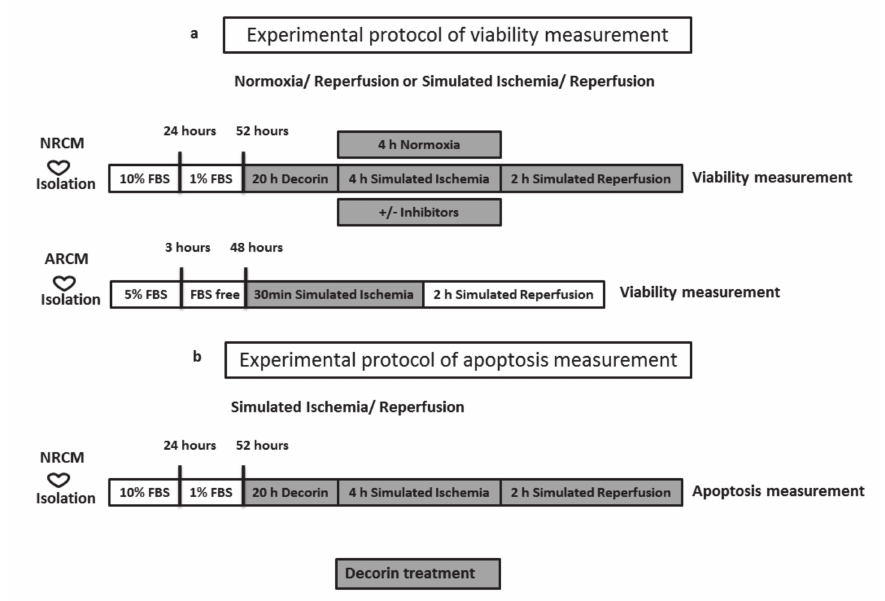
Figure 7. Experimental protocol of ( a ) viability and ( b ) apoptosis measurement. After decorin treatment cell’s viability was measured by calcein assay and apoptosis was measured by TUNEL and caspase assay. NRCM: neonatal rat cardiac myocytes, ARCM: adult rat cardiac myocytes, FBS: fetal bovine